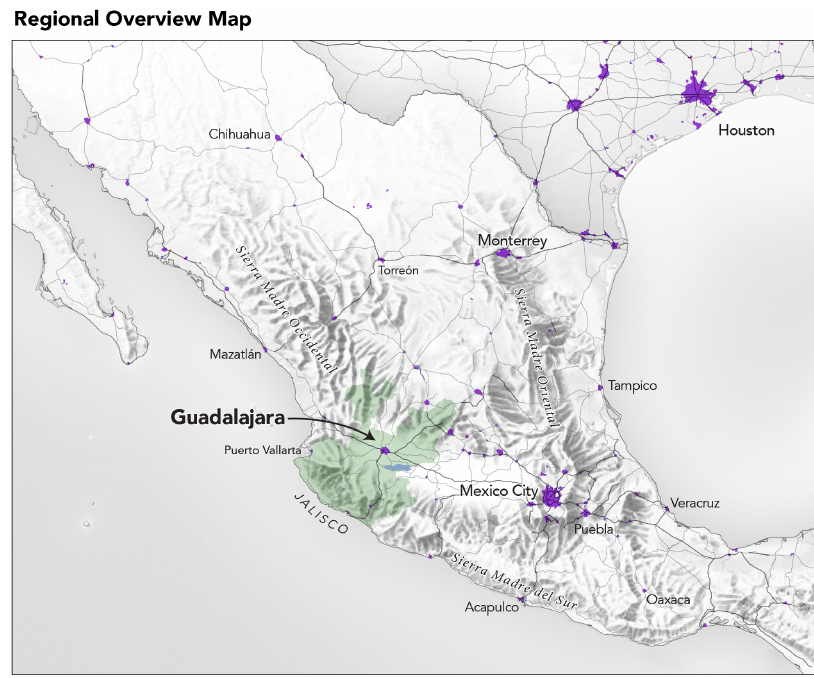
Figure 1. Regional context.